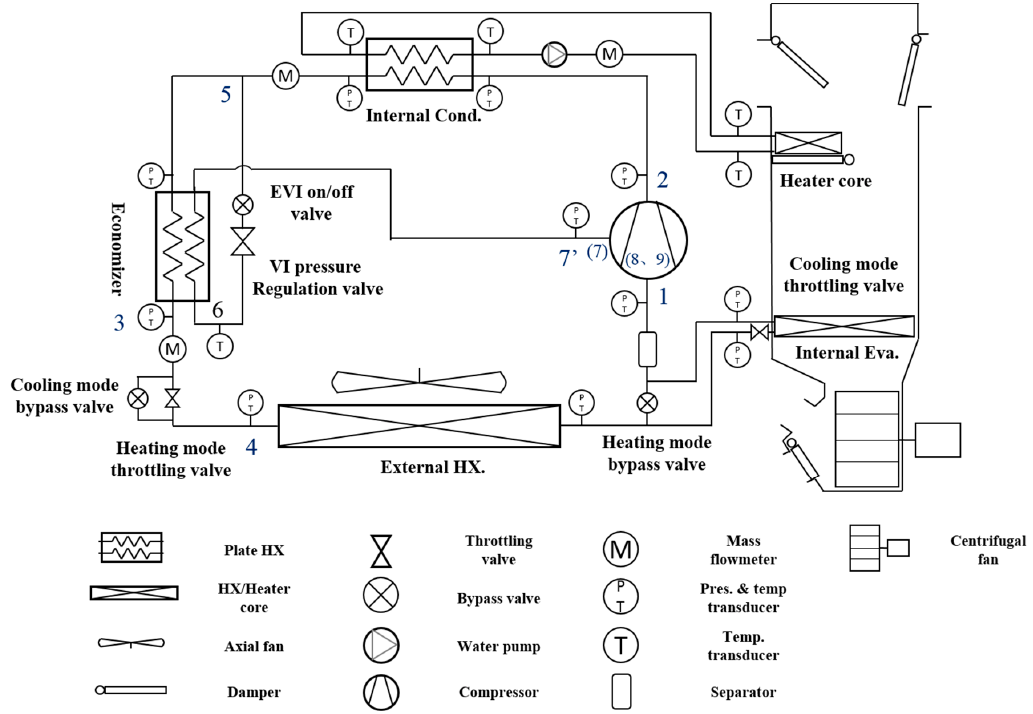
Figure 1. Sketch of economized vapor injection (EVI) vehicle air conditioning system.